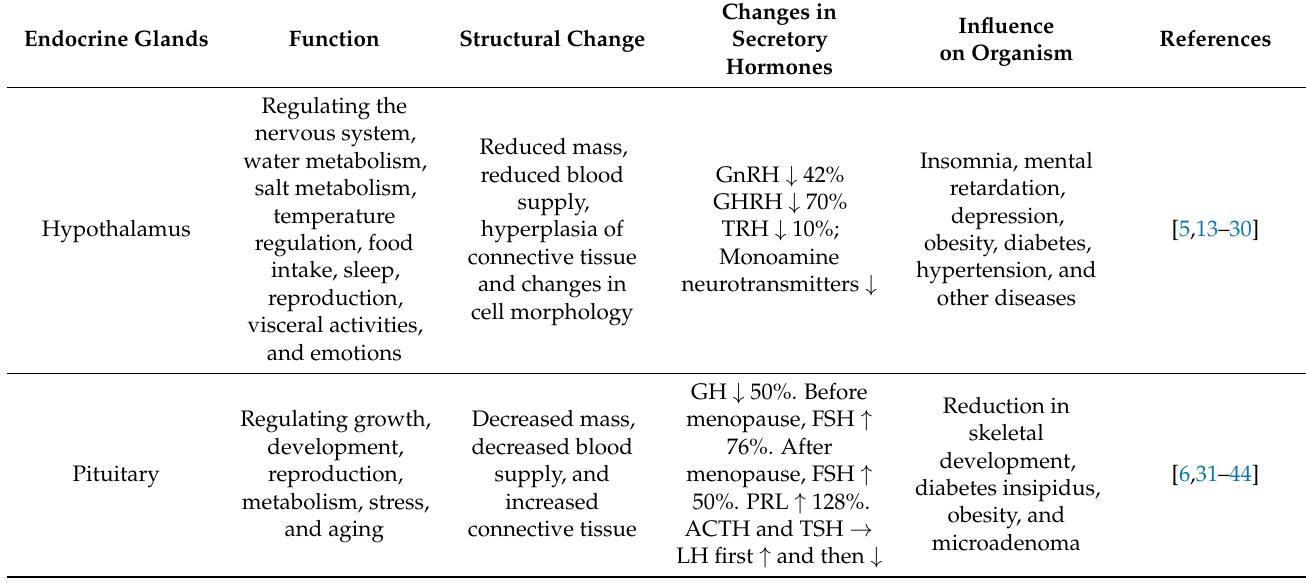
Table 1. Changes in endocrine glands during aging. ( ↓ represents decrease; ↑ represents increase; → represents